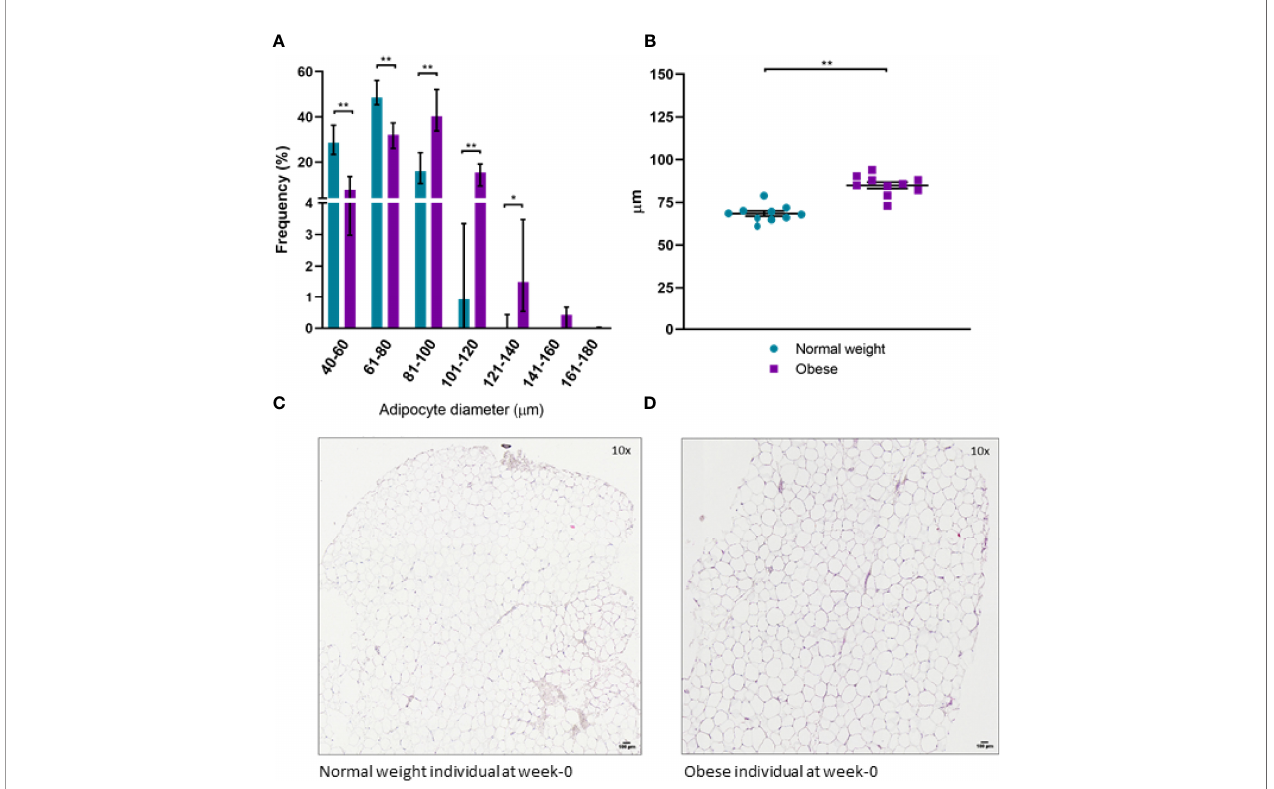
FIGURE 5 | (A) Distribution of adipocyte size in scWAT in normal weight and individuals living with obesity at week-0; (B) Average adipocyte diameter in normal weight and individuals living with obesity at week-0; (C) H&E stained section of scWAT at 10 x magni fi cation from a normal weight individual at week-0; (D) H&E stained section of scWAT at 10 x magni fi cation from an individual living with obesity at week-0. **P < 0.001, *P <